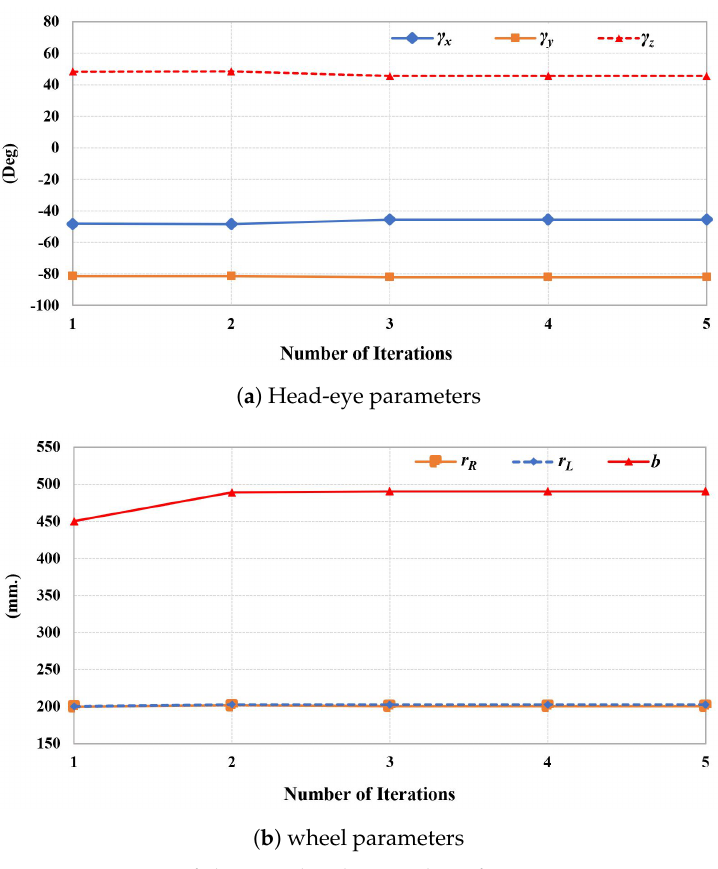
Figure 6. Rate of change related to number of iterative estimation.